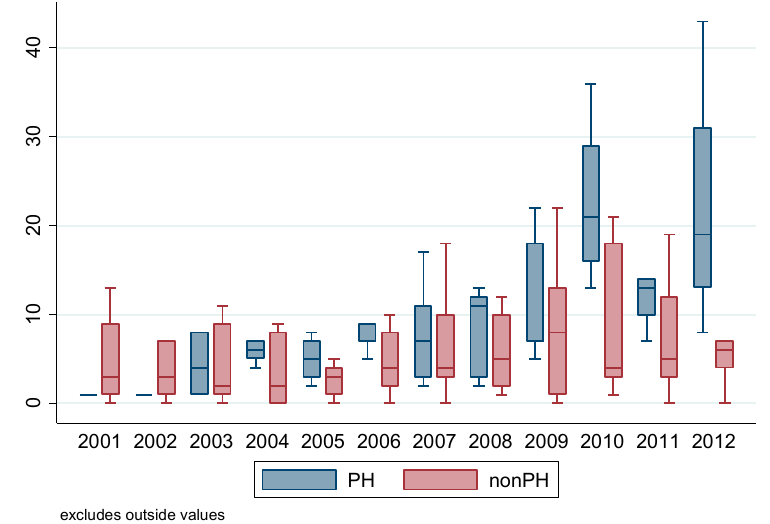
Figure 5. Trespass arrests in public housing by year. Table 5. Arellano–Bond dynamic panel-data models predicting trespass arrests.